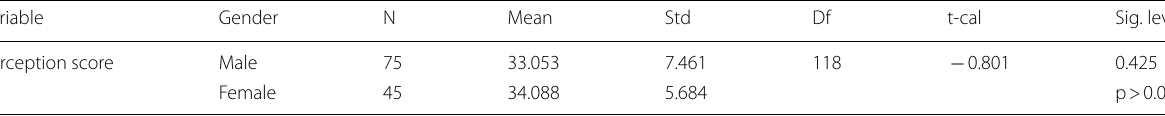
Source: Field survey (2018)